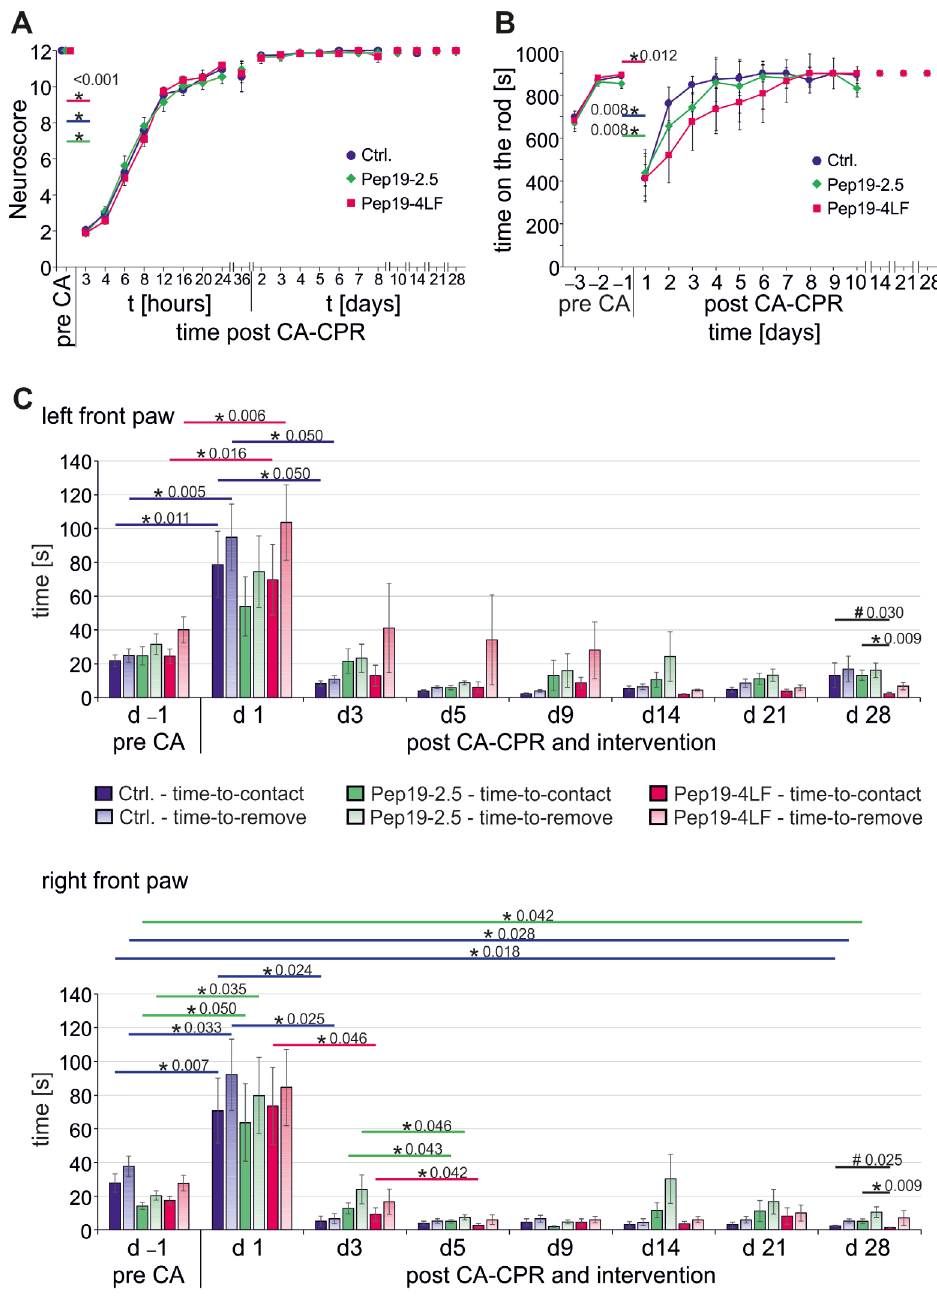
Figure 3. Neurological behavior over a 28-day observation period after CA-CPR. All graphs presented as mean ± SEM. ( A ) The NeuroScore of the animals was almost identical between the intervention groups over the observation period. ( B ) The differences in courses of RotaRod between the intervention groups after CA-CPR over the observation period were not significant ( p ≥ 0.230). ( C ) In the tape removal test, significant differences between the intervention groups in sensory perception (time-to-contact) were found bilaterally only on Day 28 after CA-CPR (# left: p = 0.030; right: p = 0.025; further pairwise analysis showed a significant difference between the two peptide-treated groups * left: p = 0.009; right: p = 0.009).